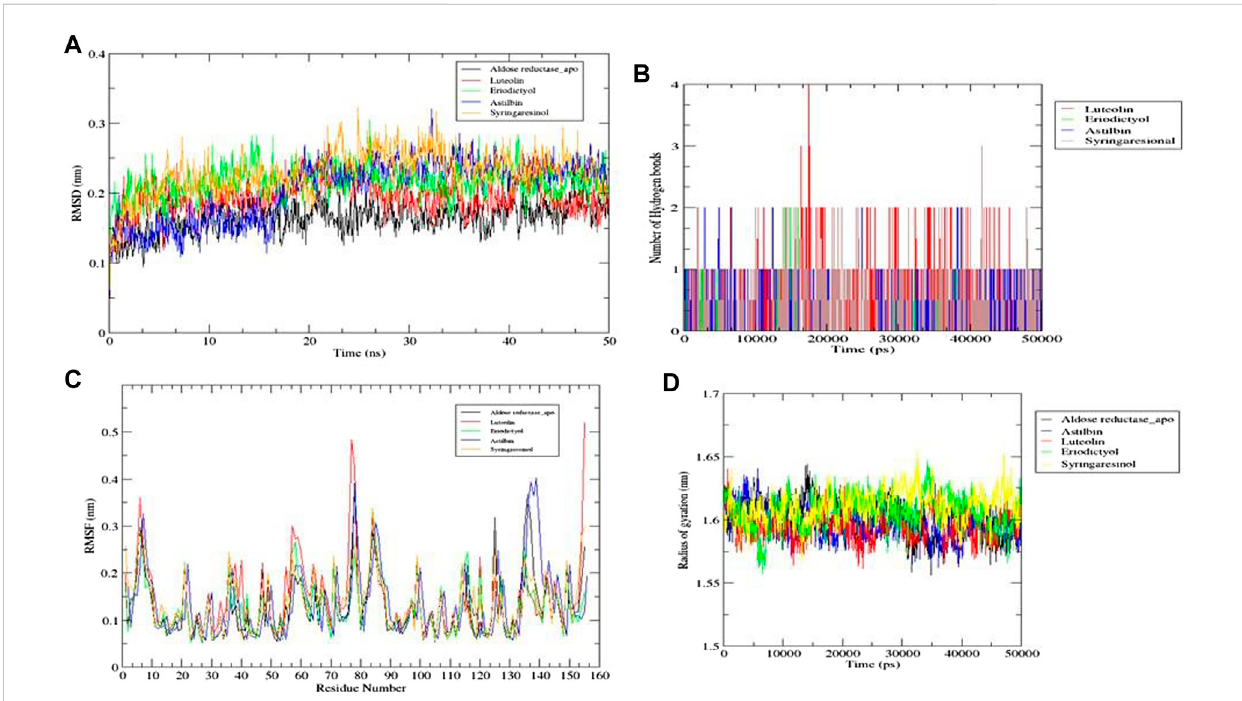
FIGURE 12 Molecular dynamics simulations. (A) RMSD graph for aldose reductase (AR) (PDB ID: 1USO) with luteolin, eriodictyol, astilbin, and syringaresinol for 50 ns. (B) RMSF graph for aldose reductase (AR) (PDB ID: 1USO) with luteolin, eriodictyol, astilbin, and syringaresinol for 50 ns. (C) Number of intermolecular hydrogen bonds between the ligands (luteolin, eriodictyol, astilbin, and syringaresinol) and amino acid residue of target protein aldose reductase (AR) (PDB ID: 1USO) for 50 ns. (D) Radius of gyration (RoG) results for luteolin, eriodictyol, astilbin, and syringaresinol with aldose reductase (AR) for 50